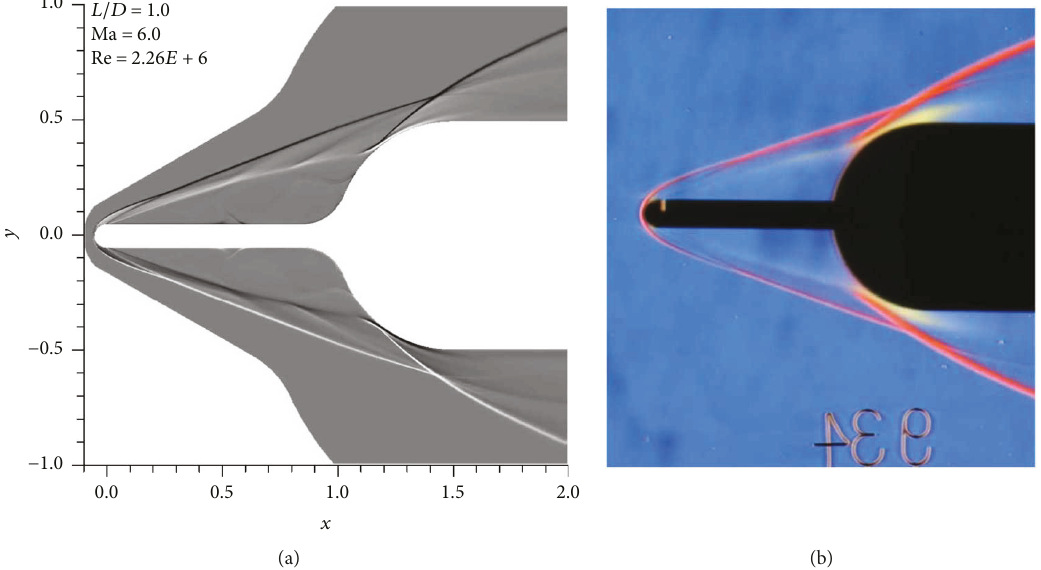
Figure 2: Flow fi eld wave structure of spiked blunt body with spike length L / D =1.0; (a) numerical Schlieren photograph; (b) experimental Schlieren photograph [20].